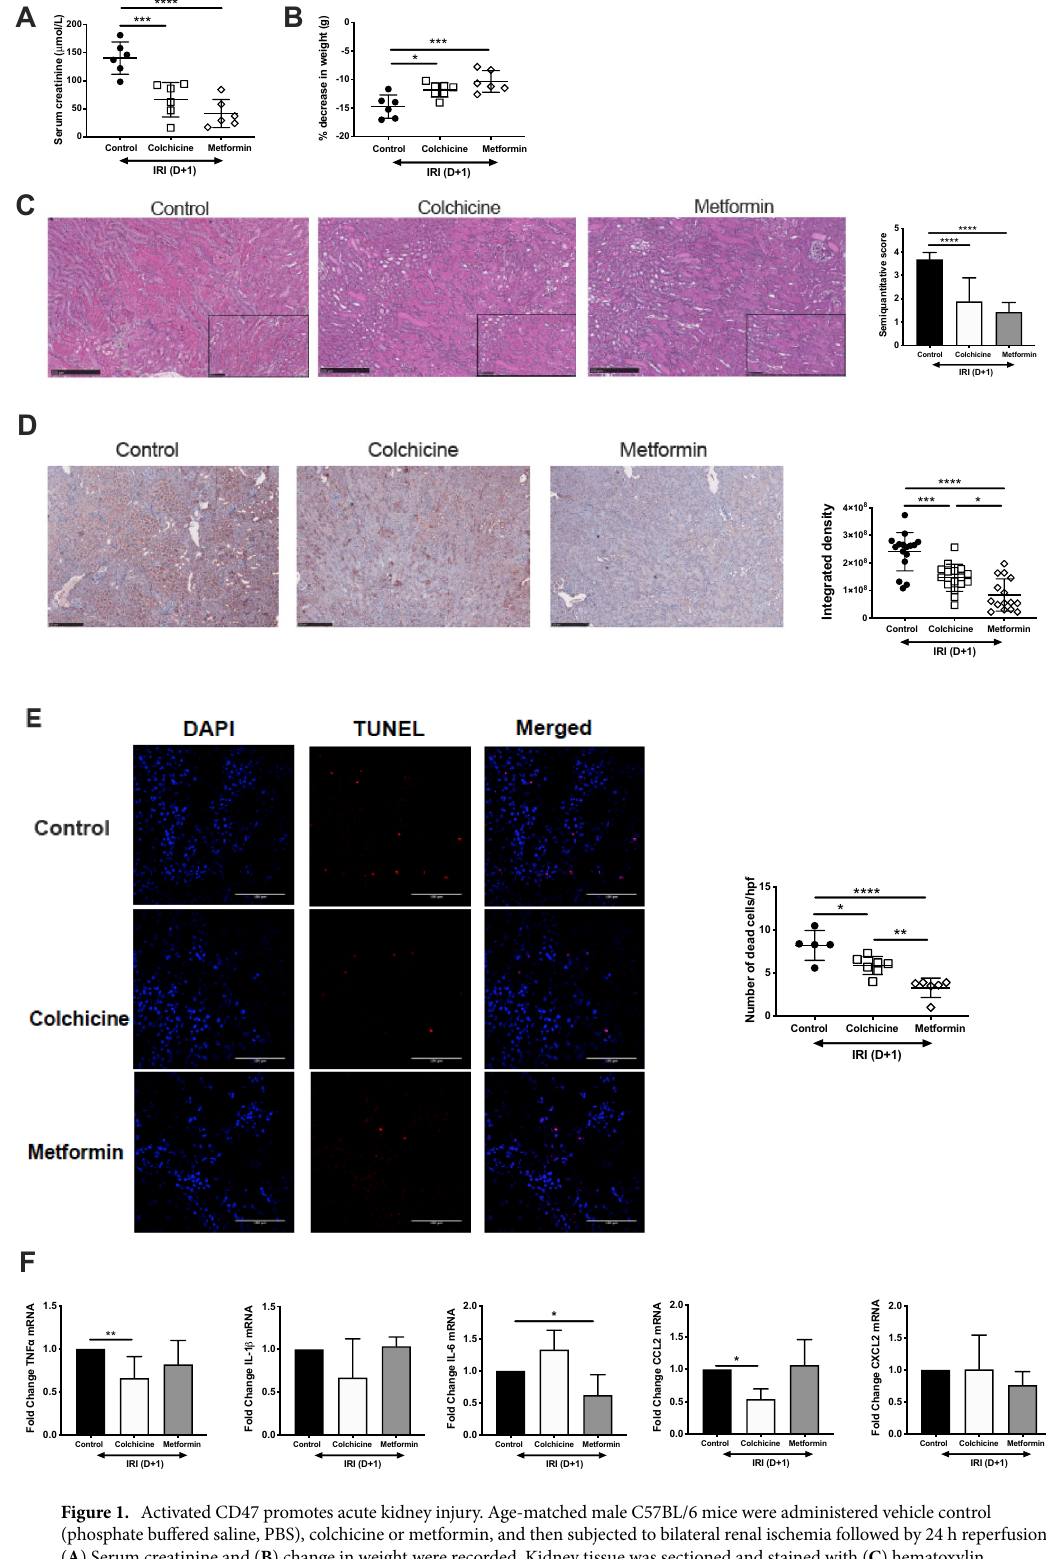
Figure 1. Activated CD47 promotes acute kidney injury. Age-matched male C57BL/6 mice were administered vehicle control (phosphate buffered saline, PBS), colchicine or metformin, and then subjected to bilateral renal ischemia followed by 24 h reperfusion. ( A ) Serum creatinine and ( B ) change in weight were recorded. Kidney tissue was sectioned and stained with ( C ) hematoxylin and eosin and ( D ) KIM-1 with semiquantitative analysis of tissue injury. Representative photomicrographs are shown, original magnification 10 × , scale bar is 250 μm; inset is 20× , scale bar is 100 μm. ( E ) TUNEL staining of kidney tissue sections were imaged by immunofluorescnce. TUNEL + cells (red) were counted from 5 randomly selected fields from n = 5 animals per group. ( F ) Whole kidney homogenate was prepared for qPCR analysis. All samples were collected for RNA isolation, cDNA synthesis and RT-PCR performed for tumor necrosis factor (TNF)-α, interleukin (IL)-1β, IL-6, CCL2, CXCL2. All data are presented as mean ± SD; ** p < 0.01, *** p < 0.001, **** p <